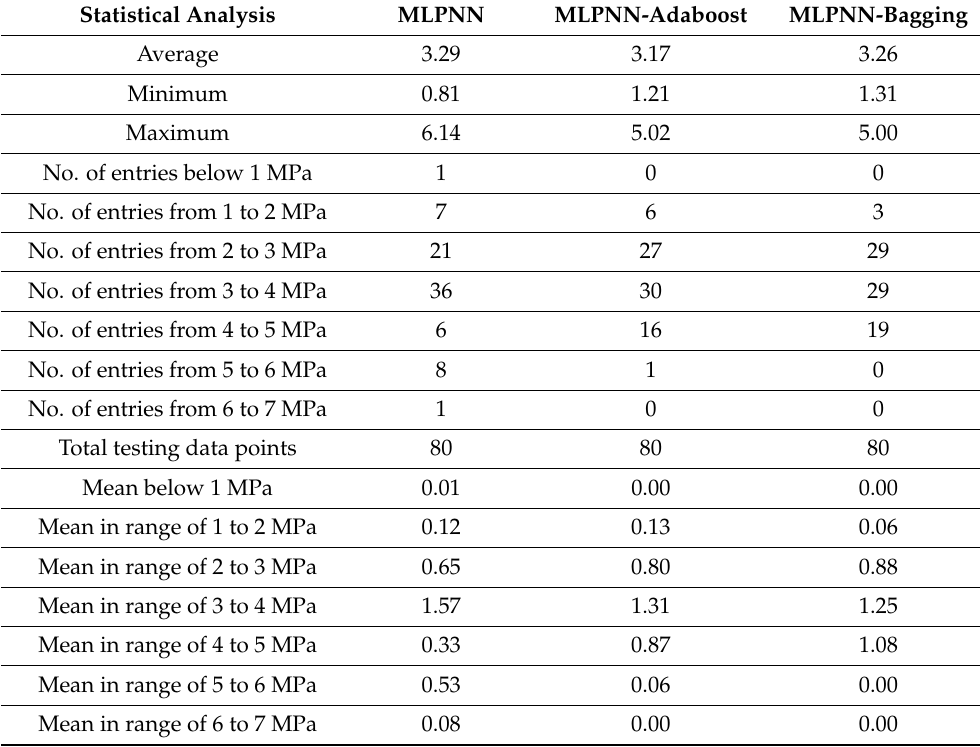
Table 12. Statistical analysis of tensile strength MLPNN